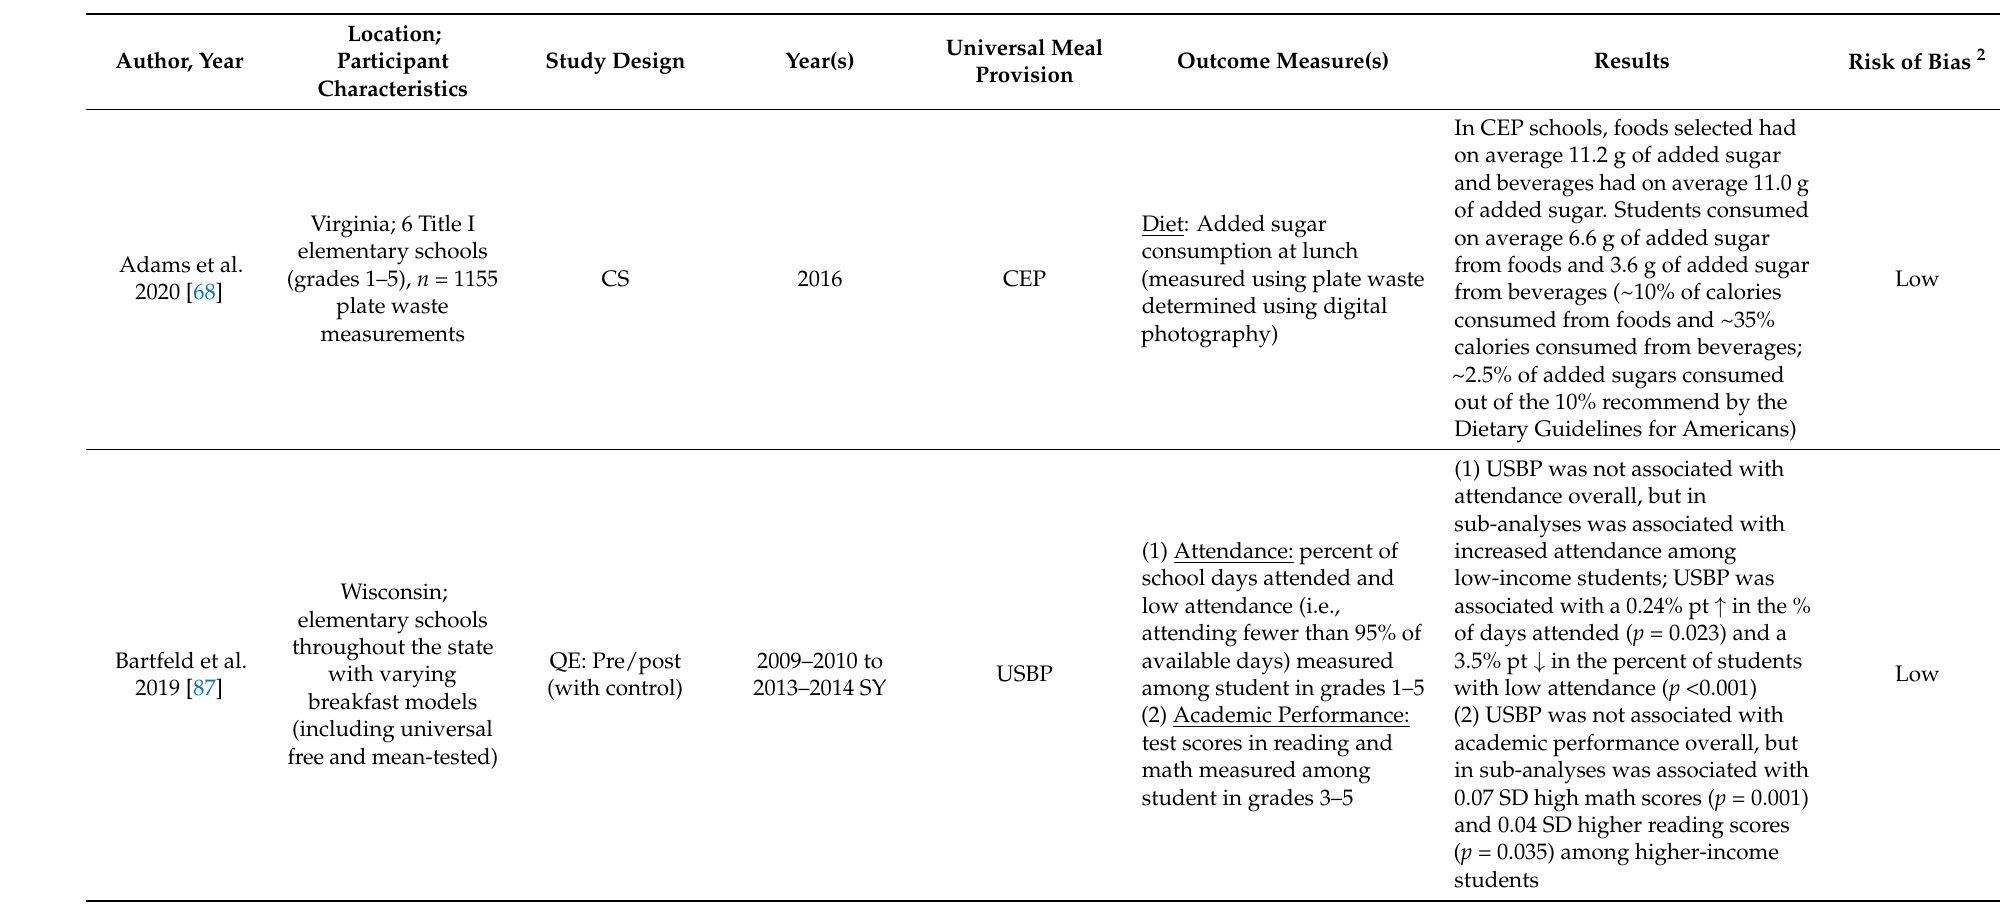
Table 1. Characteristics of studies conducted in the United States included in the systematic